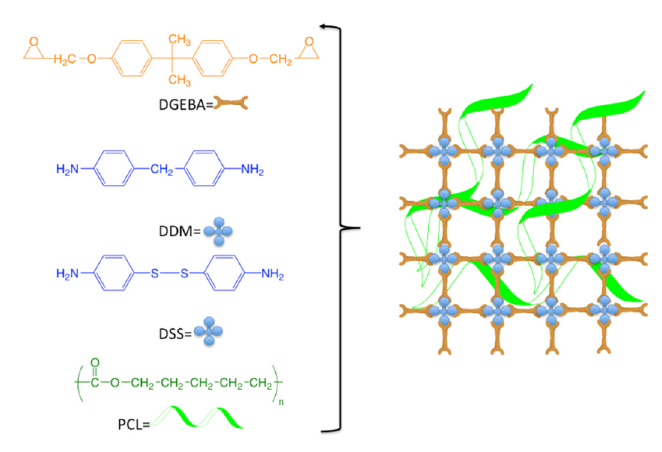
Scheme 1. Scheme of the structure of the material.